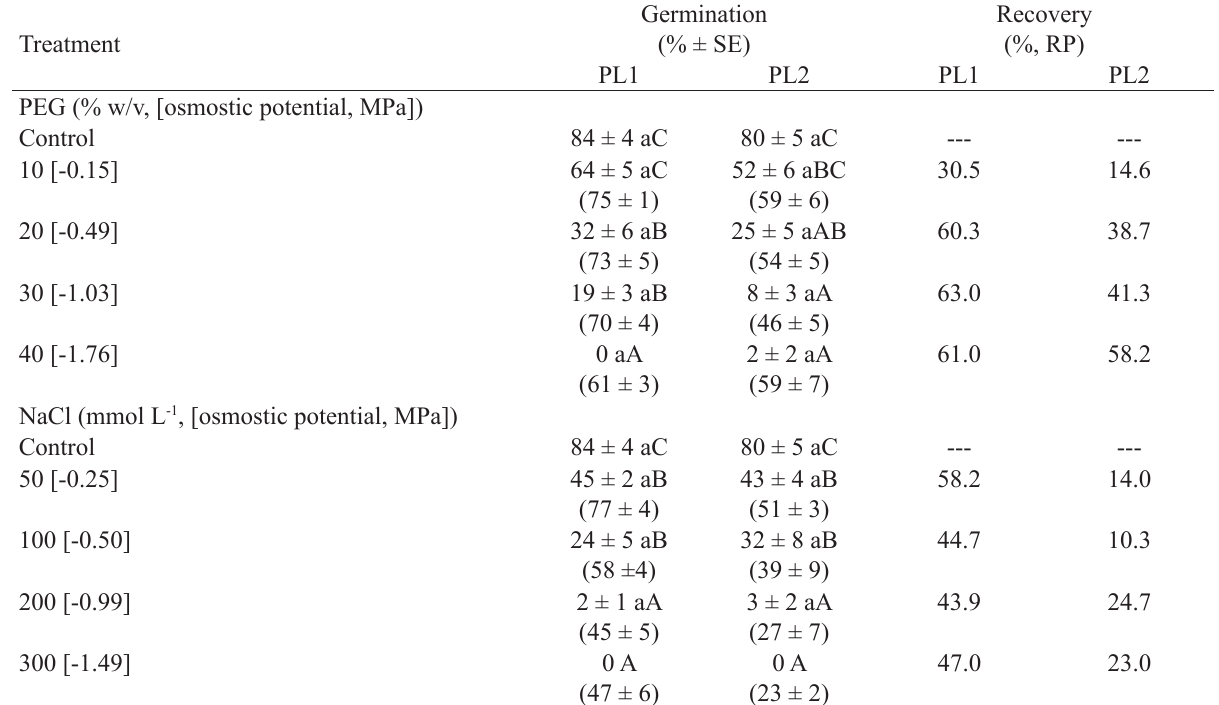
Table 4. Germination percentage of Plantago lanceolata seeds from two populations (PL1 and PL2) after incubation at 20 ºC in different PEG or NaCl concentrations for 15 days, and germination percentages (values shown in parenthesis) when non germinated seeds were incubated for other 30 days in distilled water (total incubation period of 45 days). For each treatment (PEG or NaCl), mean values within a column followed by the same uppercase letter are not significantly different from each other ( P > 0.05), and mean values within a row followed by the same lowercase letter are not significantly different ( P >